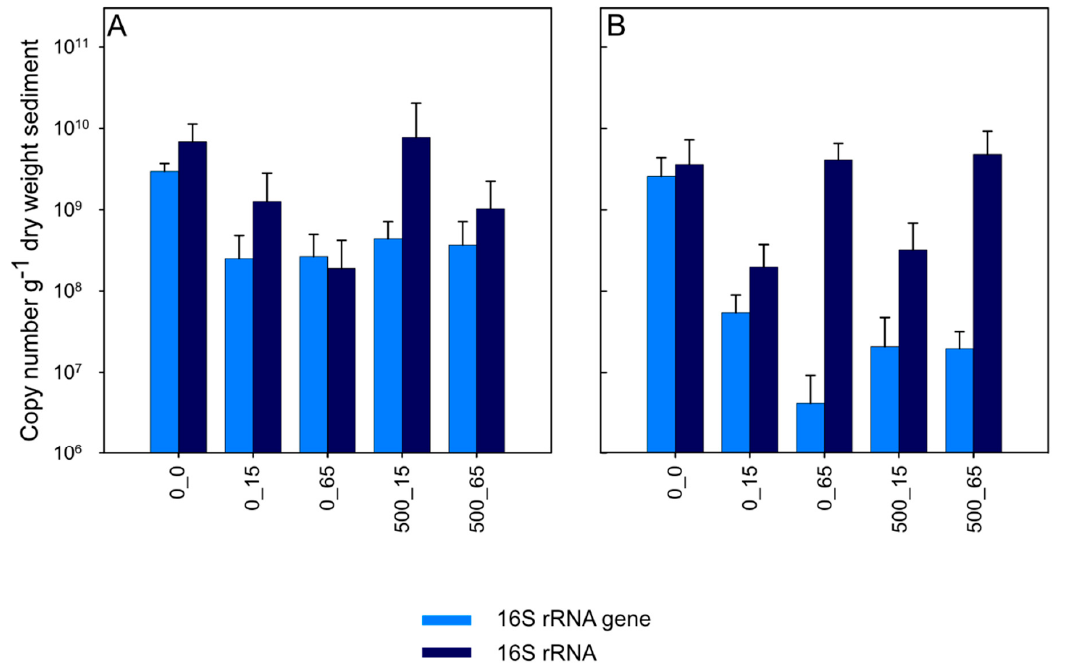
Figure 2. Abundance (copy numbers) of bacterial 16S rRNA genes and 16S rRNA detected in oxic hyporheic zone microcosms containing ( A ) surface and ( B ) subsurface sediment samples. Sample code: 0, 500 indicate supplemental TrOC concentrations in µg L –1 . 0, 15, 65 represent sampling days. Values are the arithmetic means of triplicate incubations. Error bars indicate standard deviations.